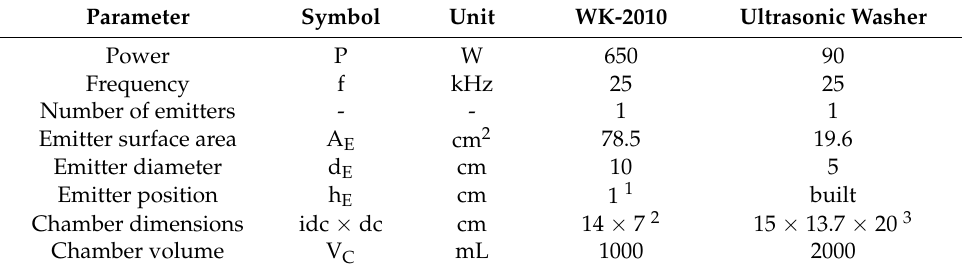
Table 3. Technical characteristics and operating conditions of the experimental ultrasonic